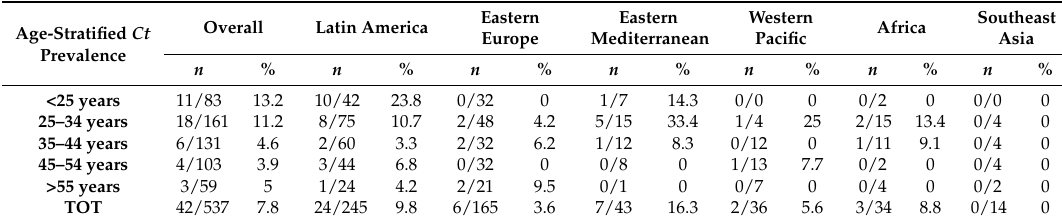
Table 3. Age-stratified C. trachomatis prevalence of 537 women enrolled: overall and by geographical WHO